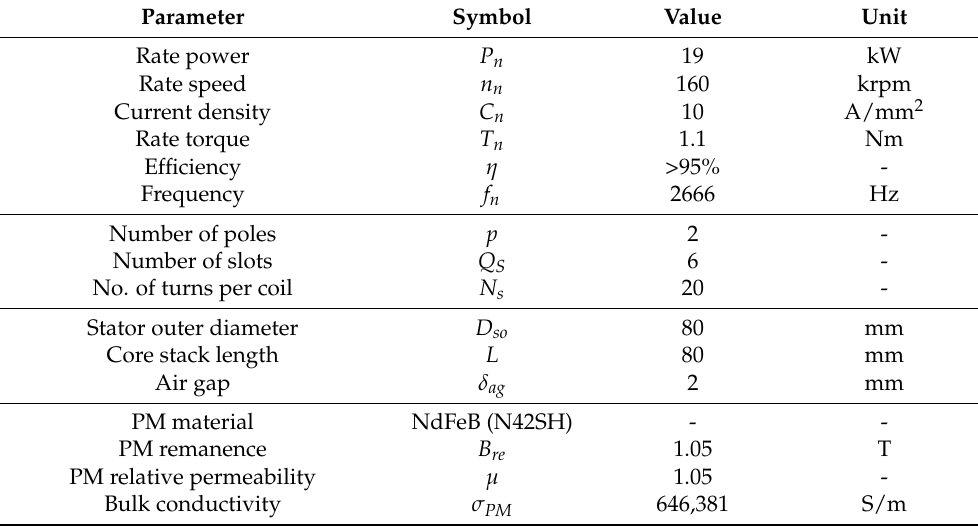
Table 1. HSPMSM specifications.